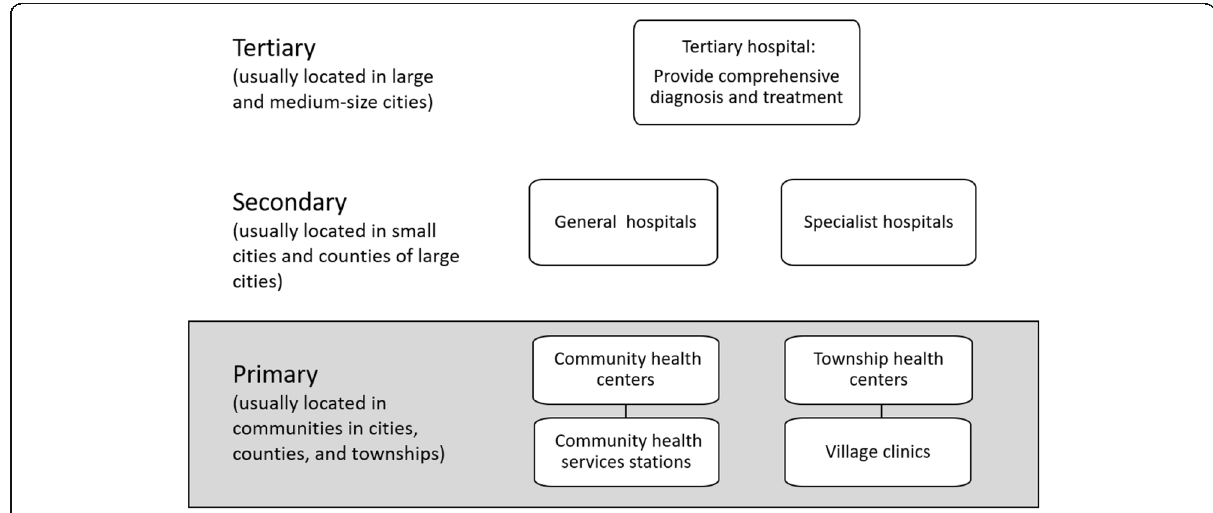
Fig. 1 Structure of the Chinese Health